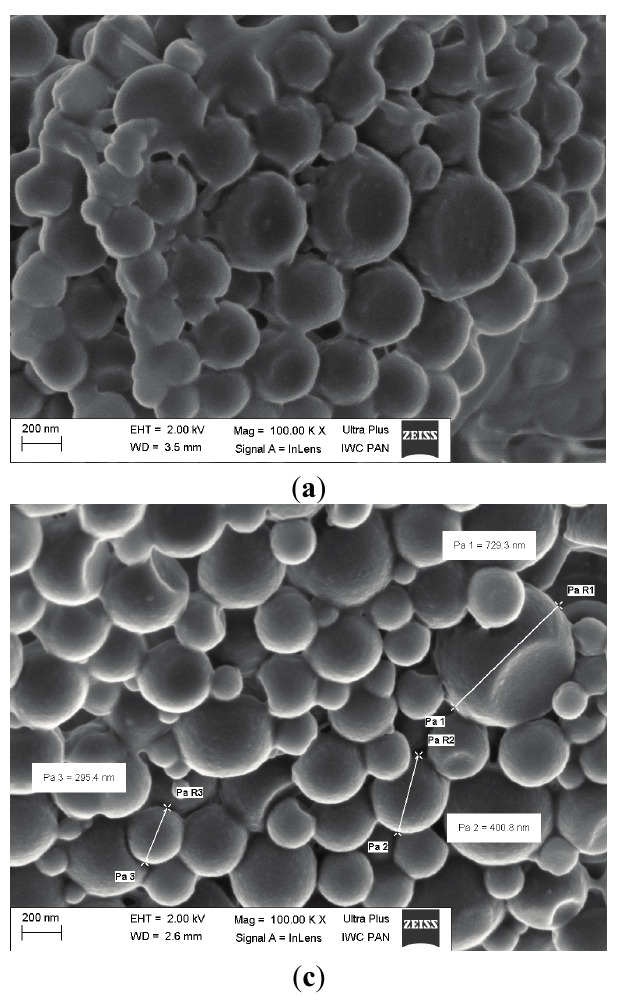
Figure 2. SEM images of CPZ-HCL-loaded PLGA prepared with PLGA